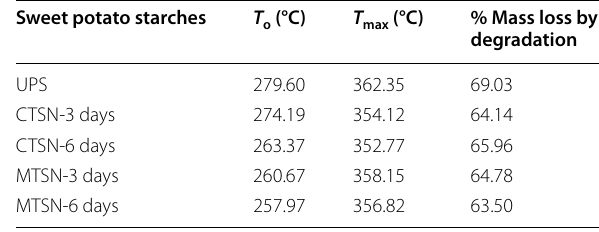
T o , onset of degradation temperature; T max , maximum temperature of